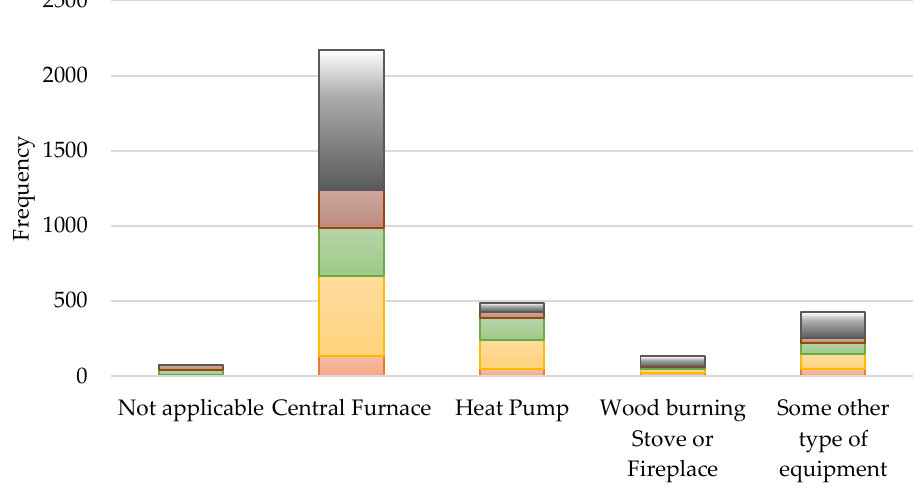
Figure 7. Box plot for the number of household members per climate region.